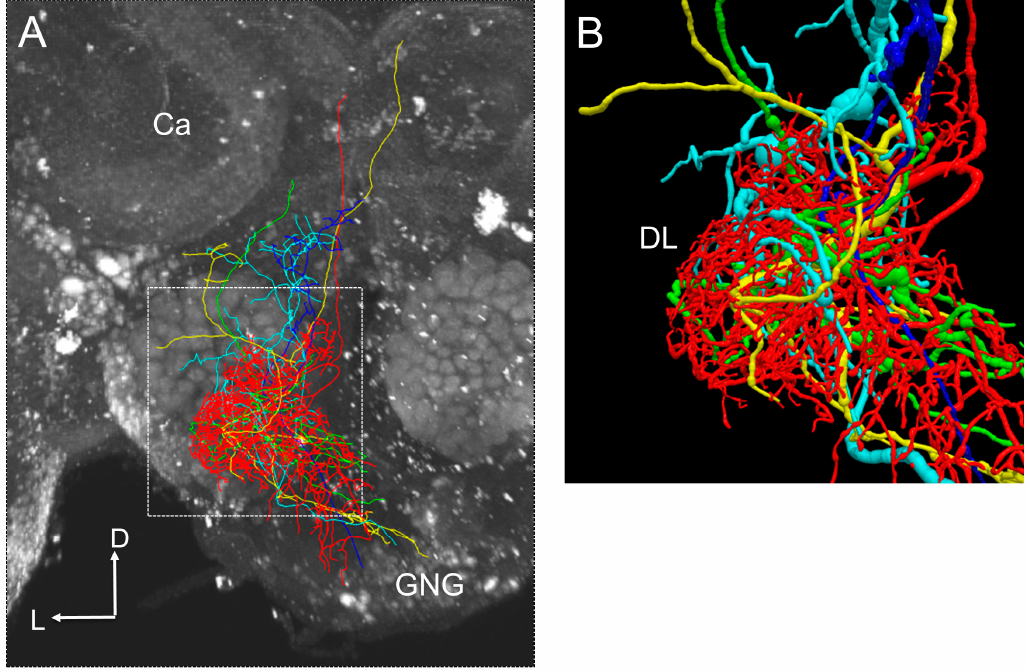
Figure 4. ( A ) An example of interneurons shown a response to a vibration stimulus presented to the antenna. Each interneuron is shown in a different color. ( B ) Zoom of arborization area of interneurons in the antennal mechanosensory center of the honeybee brain. Presumable synaptic connections could be estimated from locations of neurite terminals.